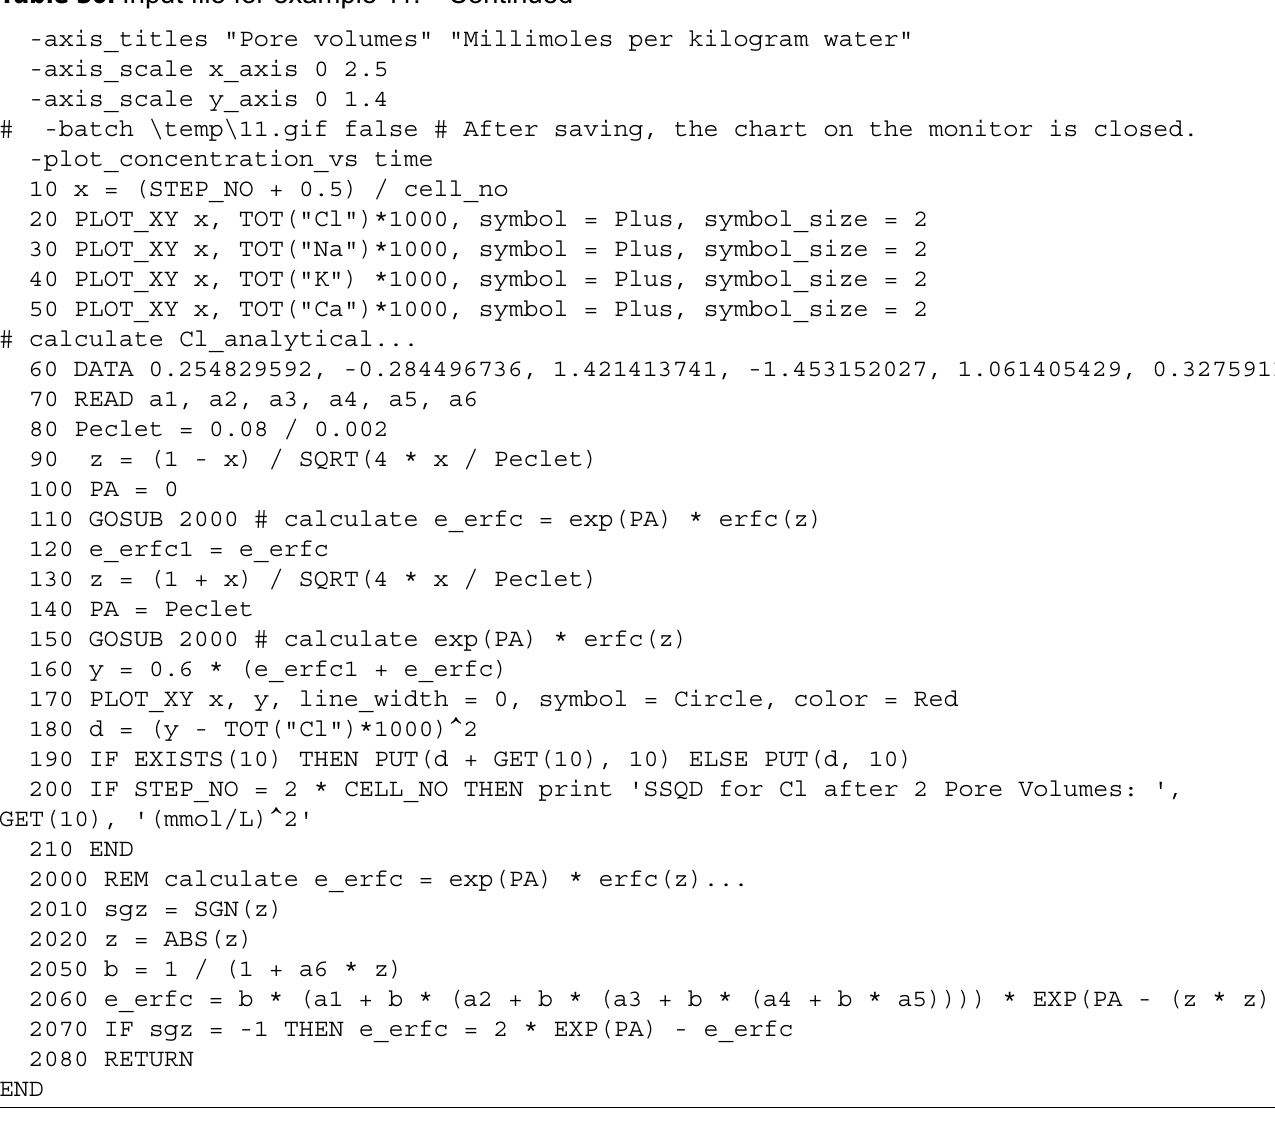
Table 30. Input file for example